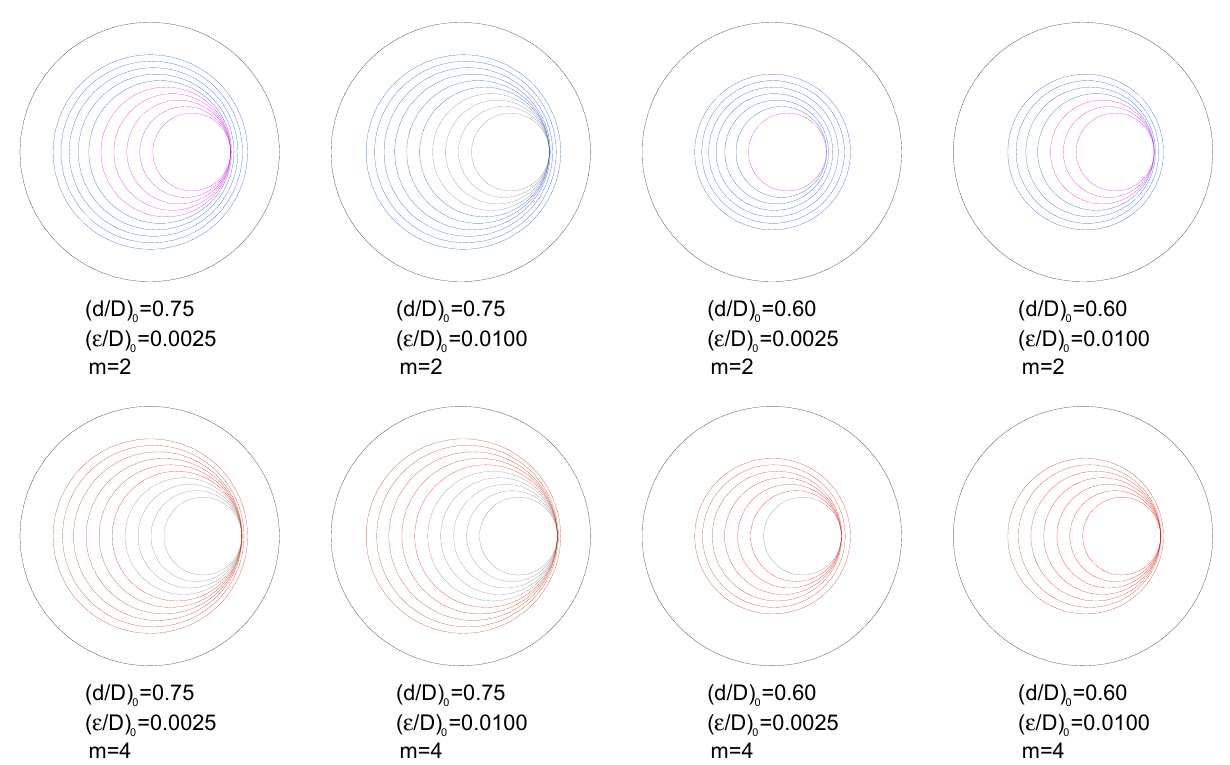
Figure 9. Crack fronts for remote tensile loading ; m = 2: no contact in blue, partial contact in pink, and full contact in grey; m = 4: no contact in brown, partial contact in red, and full contact in grey.